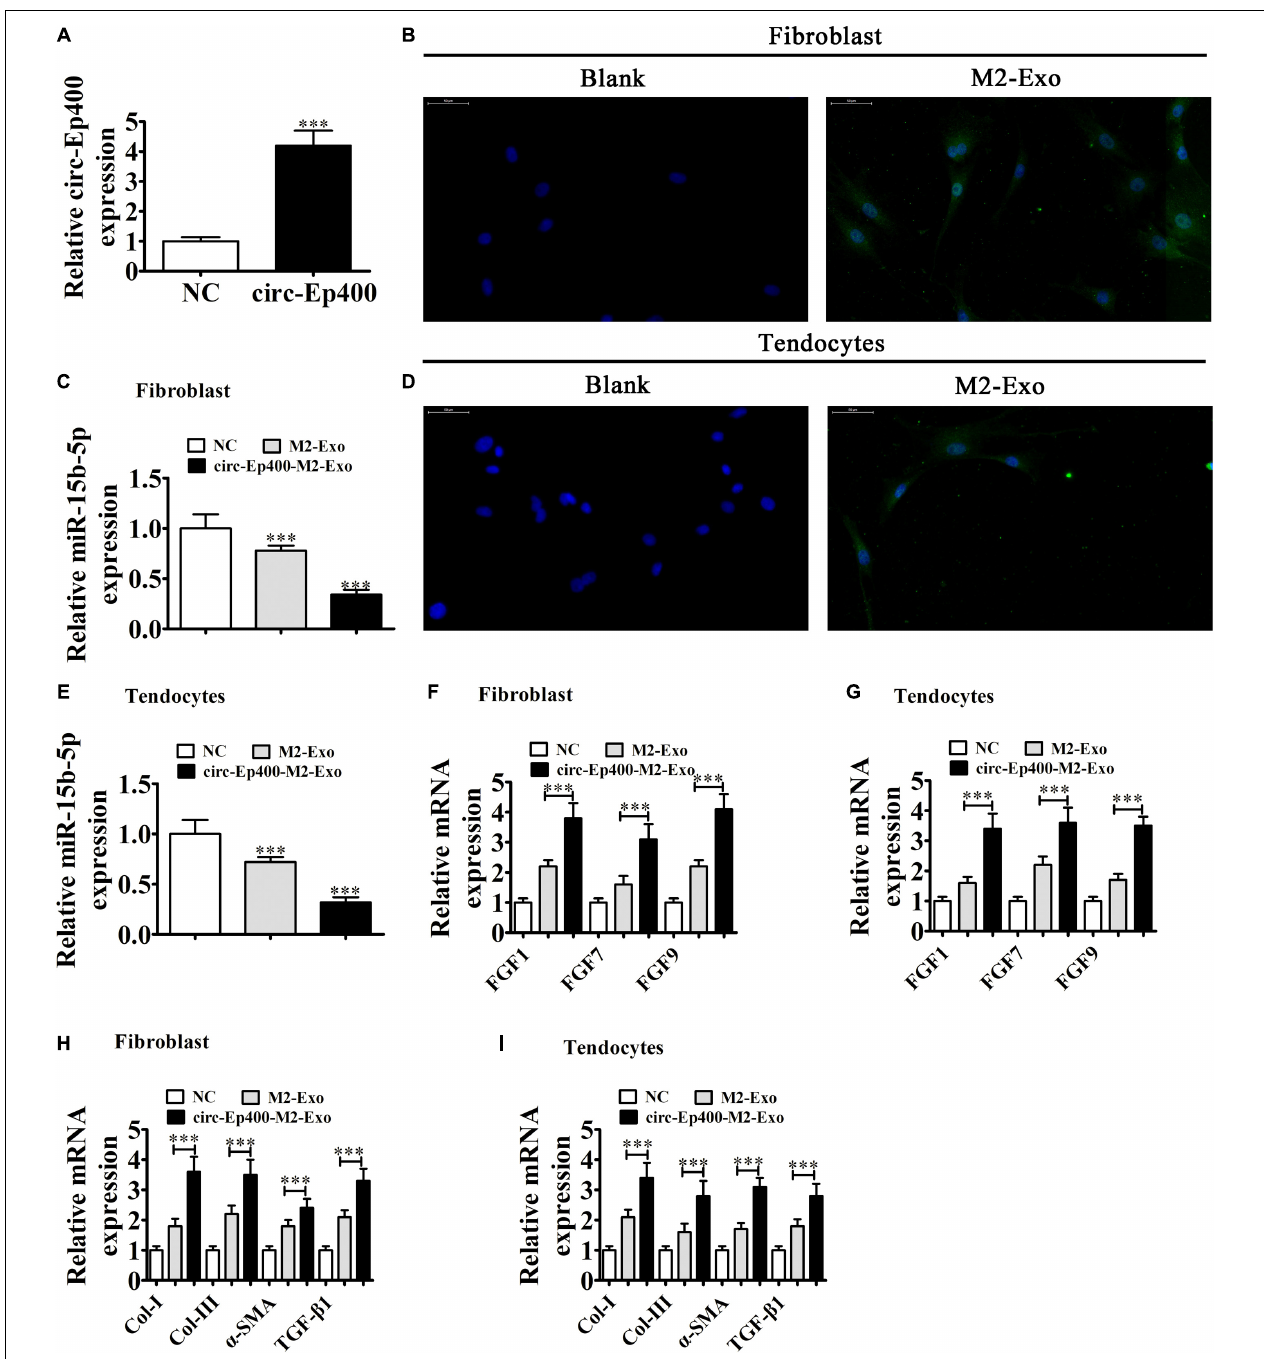
FIGURE 5 | M2 macrophage-derived circRNA-Ep400-containing exosomes promote profibrotic activity in tenocytes and fibroblasts in vitro . (A) RT-qPCR showing the circRNA-Ep400 expression in exosomes derived from M2 macrophages (NC) or overexpressed circRNA-Ep400 M2 macrophages. The results are expressed as the mean ± SD. ∗∗∗ P < 0.001 vs. NC. (B) Fibroblasts were transfected with PKH26-labeled exosomes. (C) RT-qPCR showing the miR-15b-5p expression after treatment with exosomes from M2 macrophages or overexpressed circRNA-Ep400 M2 macrophages. The results are expressed as the mean ± SD. ∗∗∗ P < 0.001 vs. the NC. (D) Tenocytes transfected with PKH26-labeled exosomes. (E) RT-qPCR showing miR-15b-5p expression after treatment with exosomes from M2 macrophages or overexpressed circRNA-Ep400 M2 macrophages. The results are expressed as the mean ± SD. ∗∗∗ P < 0.001 vs. the NC. (F,G) RT-qPCR showing FGF1, FGF-7, and FGF-9 expression in both fibroblasts and tenocytes after treatment with exosomes from M2 macrophages or overexpressed circRNA-Ep400 M2 macrophages. The results are expressed as the mean ± SD. ∗∗∗ P < 0.001. (H,I) RT-qPCR showing the Col-I, Col-III, and α -SMA, as well as TGF- β 1 expression levels in both tenocytes and fibroblasts after treatment with exosomes from M2 macrophages or overexpressed circRNA-Ep400 M2 macrophages. The results are expressed as the mean ± SD. ∗∗∗ P < 0.001.